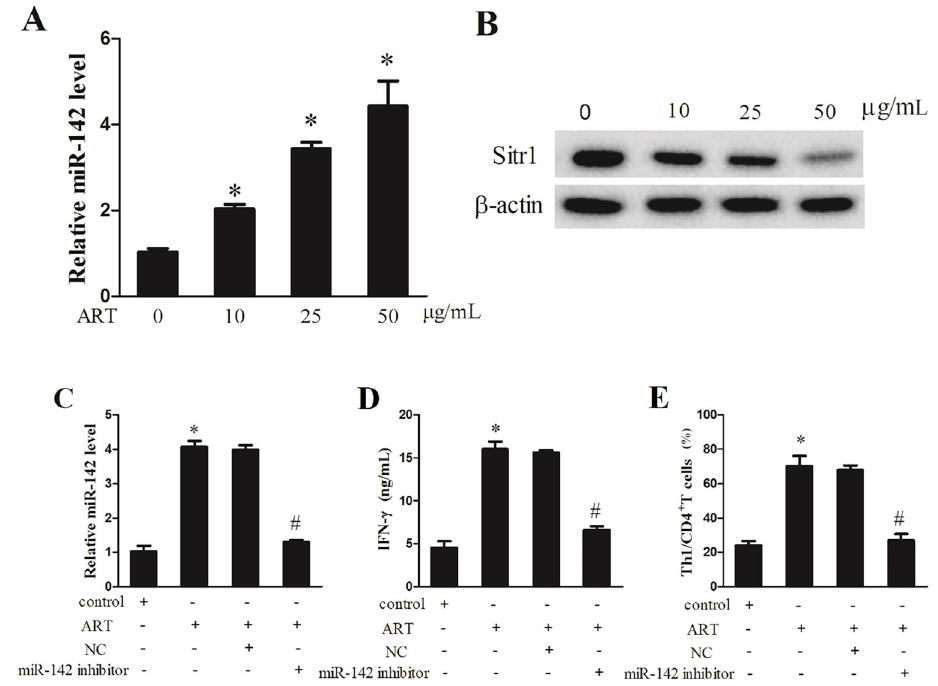
Figure 3. Artesunate (ART) suppressed Sirt1 level by up-regulating miR-142 to induce Th1 differentiation. A , Expression of miR-142 was detected by qRT-PCR. B , Sirt1 protein level was determined using western blot. CD4 + T cells were transfected with miR-142 inhibitor or its negative control (NC). C , Expression of miR-142 was determined by qRT-PCR. D , The IFN- g level in culture supernatant was examined by ELISA. E , The proportion of Th1/CD4 + Tcells was analyzed using fl ow cytometry. Data are reported as means ± SD. *P o 0.05 compared to 0% ART ( A ) or to control ( C – E ); # P o 0.05 compared to ART + NC